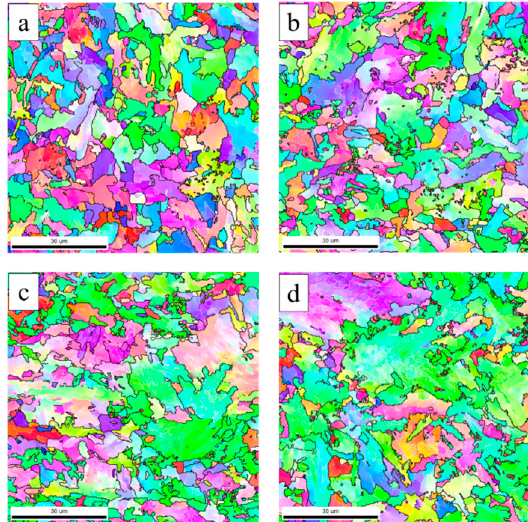
Figure 6. Typical IPF maps for samples comprising ( a ) 0.15 wt.% Si, ( b ) 0.36 wt.% Si, ( c ) 0.48 wt.% Si, and ( d ) 0.77 wt.% Si.